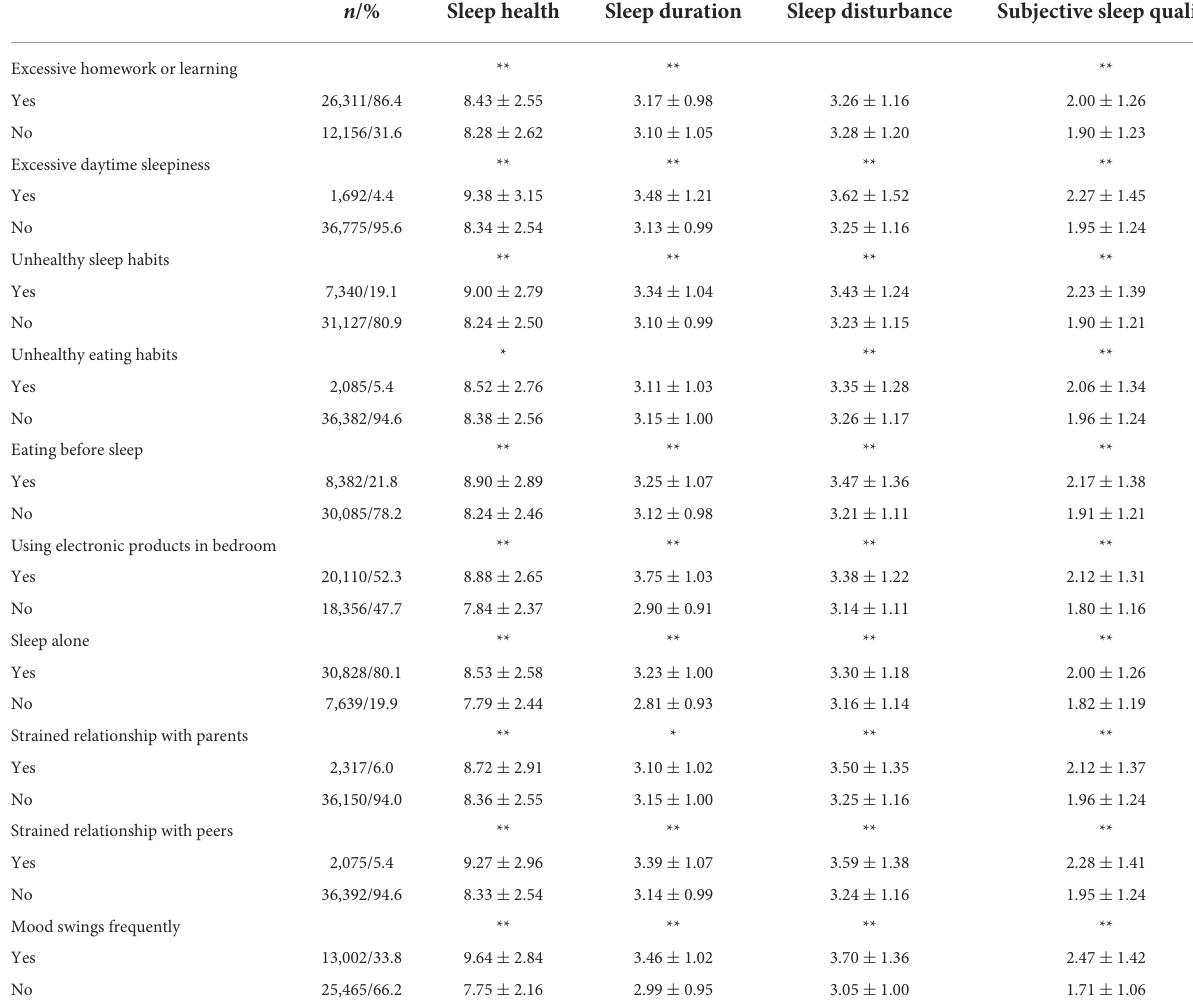
TABLE 3 Univariate analysis of the factors associated with sleep characteristics. n /% Sleep health Sleep duration Sleep disturbance Subjective sleep